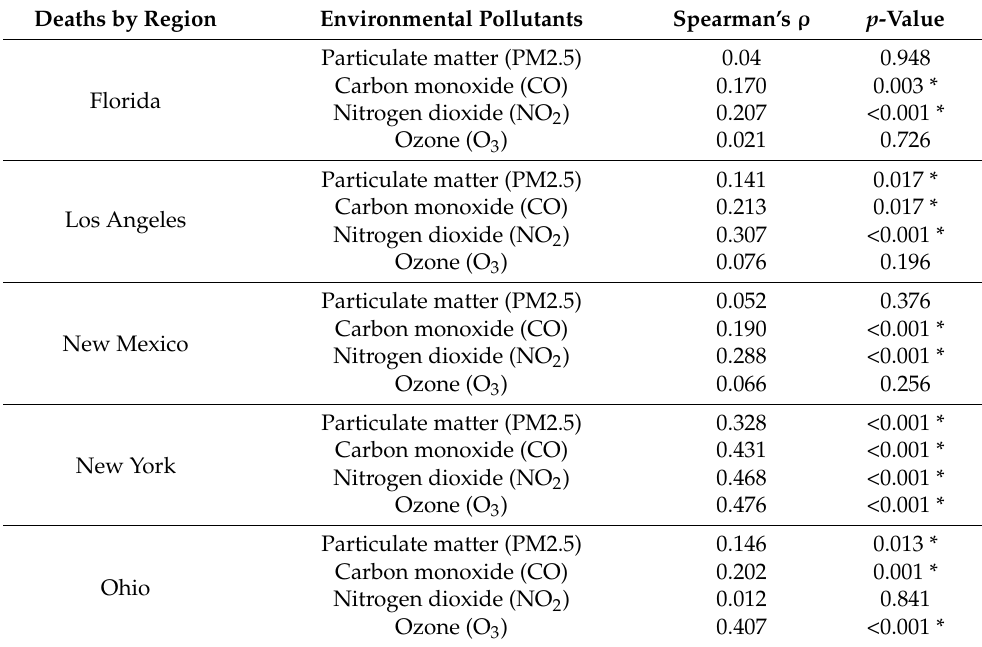
Table 2. Correlation of PM2.5, CO, NO 2 and O 3 with the number of deaths due to SARS-CoV-2. Deaths by